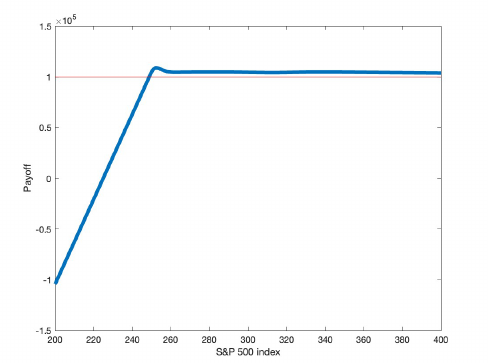
Figure 2. The payoffs of the optimal portfolios as functions of the S&P 500 index.